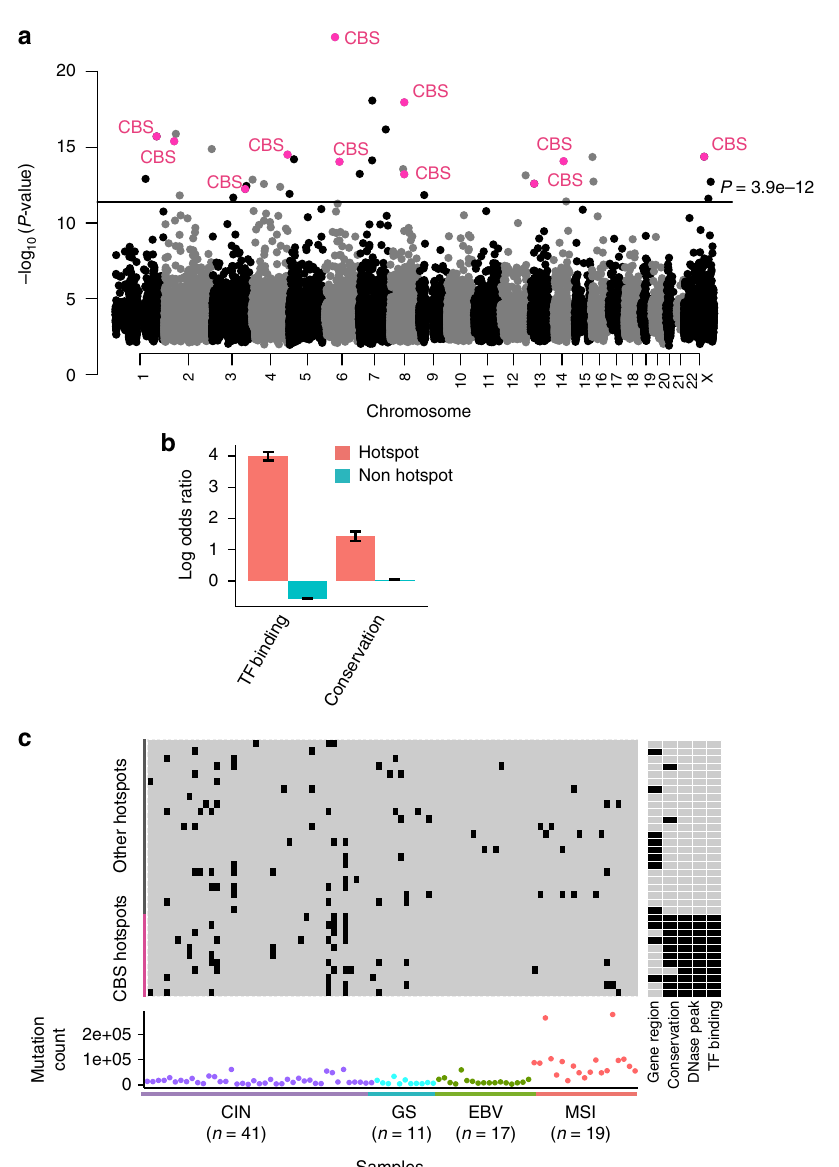
Fig. 3 Genome-wide analysis of non-coding SNV hotspots. a The negative log P -values of SNV recurrence for all 21 bp regions genome-wide, only regions with at least three mutations are displayed. Signi fi cantly mutated hotspots overlapping CBSs are highlighted. The horizontal line marks the Bonferroni adjusted P -value of 0.01. b Log odds ratio of the enrichment of hotspot mutations and non-hotspot mutations in transcription factor binding regions and conserved regions. Error bars indicate the s.e.m of the log odds ratio. c Gastric cancer samples sorted by molecular subtype, with each row representing a signi fi cant mutation hotspot. Mutated samples are highlighted in black in the matrix. The mutation load of each sample is shown in the bottom panel. The right panel annotates the location of each hotspot with respect to annotated functional